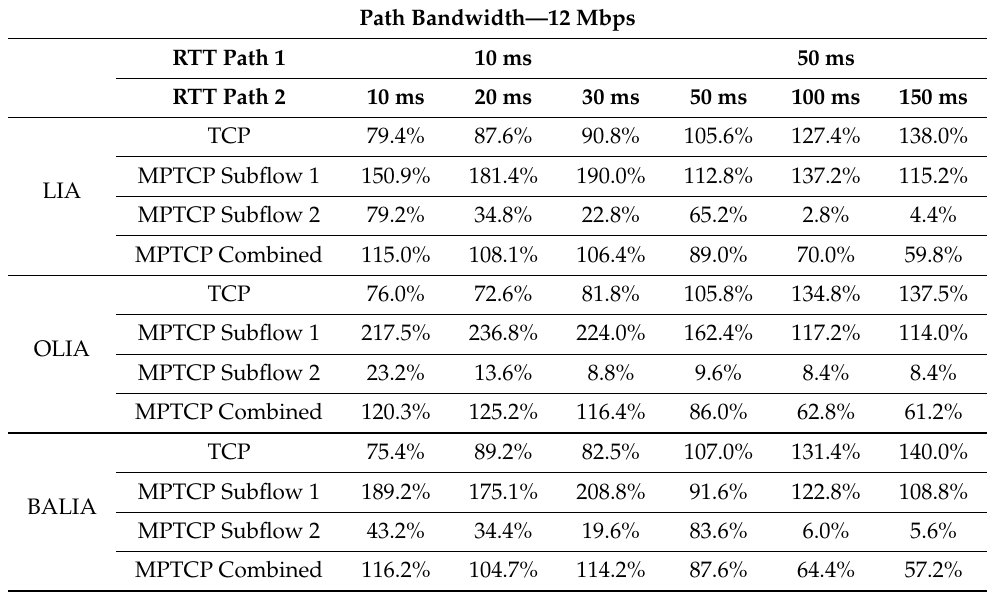
Table 4. Share of 12 Mbps bandwidth attained at Switch One-Shared Paths.